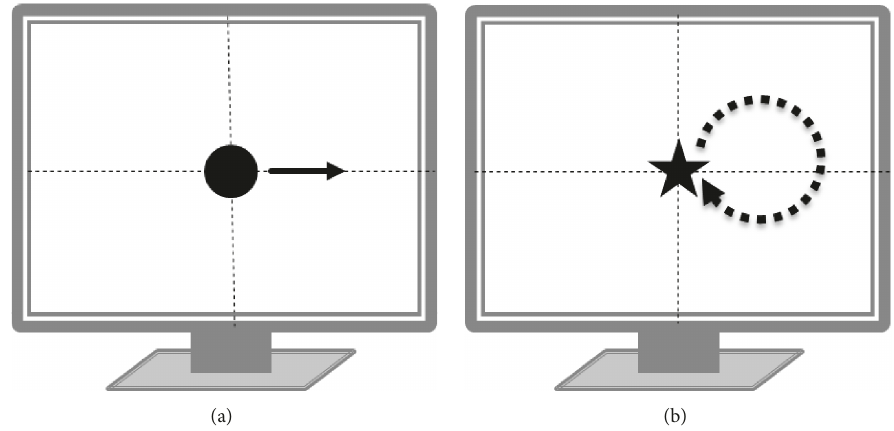
Figure 3: (a) Dot detection task. The patient was tested to see if motion of a visual stimulus affected her visual ability. A small black dot 0.4 cm in diameter was presented in the center of the screen for 3 seconds with no motion (stationary condition) or with right side lateral motion with a velocity of 2 cm/sec (moving condition). (b) Figure recognition task. The patient was tested to see if motion of a figure could influence herability to identify it. Fourdifferent figures black in color were prepared; a circle,a star, a triangle, and a square, each of which was inscribed in a circle with a diameter of 1 cm. Each figure was presented in the center of the screen with no motion for 4 seconds (stationary condition) or with clockwise rotatory movement from the center tracing on a circle of 4 cm diameter with a velocity of 2 cm/sec for 4 seconds (moving